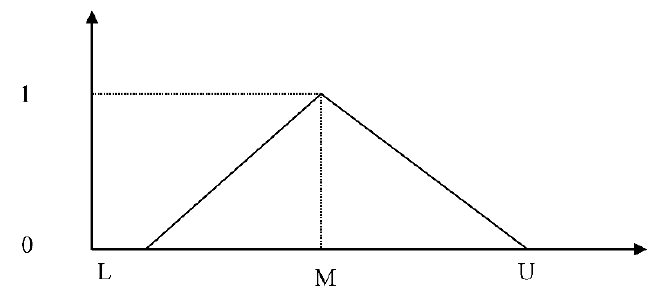
Figure 4. Fuzzy triangular number.